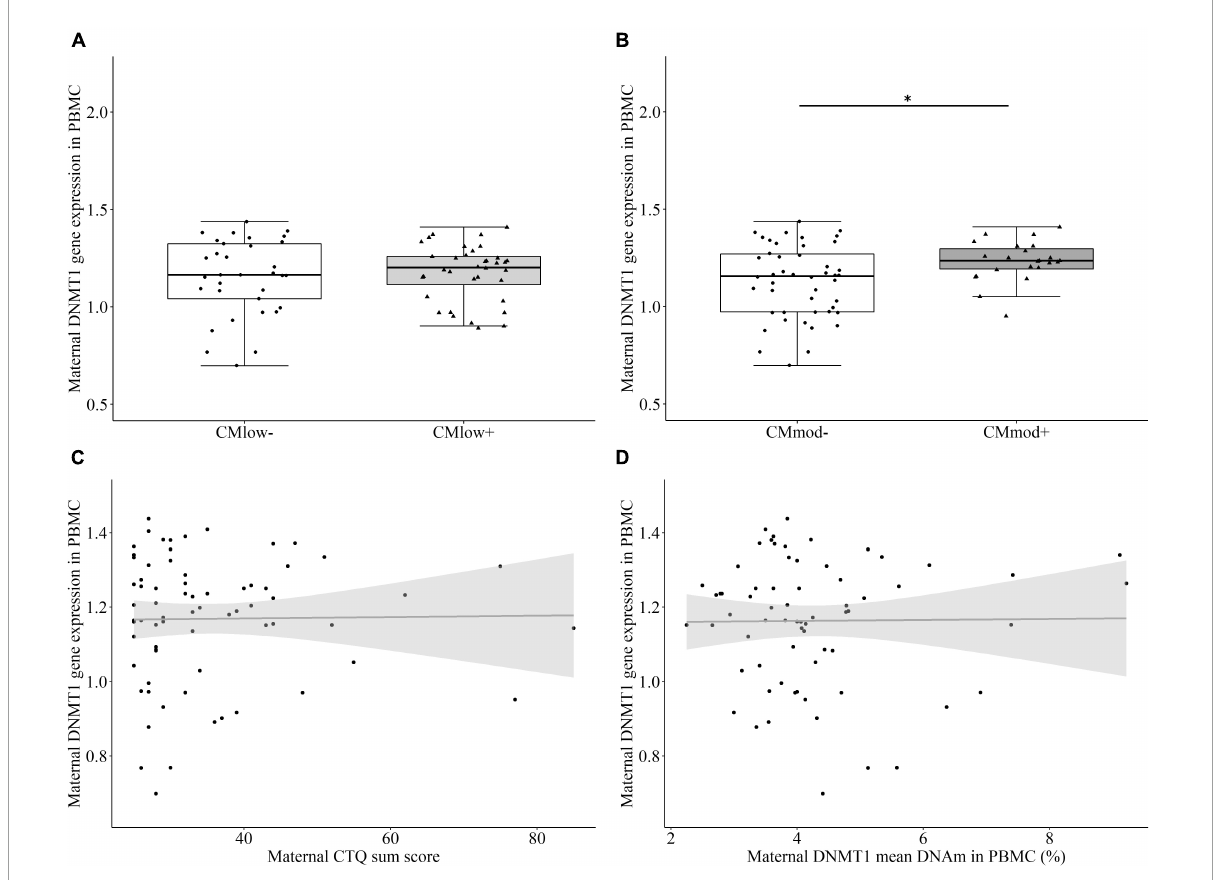
FIGURE2 DNA methyltransferase 1 ( DNMT1 ) relative gene expression in peripheral blood mononuclear cells (PBMC) of the mothers. (A) There was no significant difference between CM low - and CM low + mothers in terms of their DNMT1 relative gene expression levels. (B) CM mod - mothers had lower DNMT1 relative gene expression compared to CM mod + mothers ( p = 0.015). (C) DNMT1 relative gene expression did not have a significant correlation with CTQ sum score ( r s = 0.034, p = 0.782). (D) DNMT1 relative gene expression did not have a significant correlation with